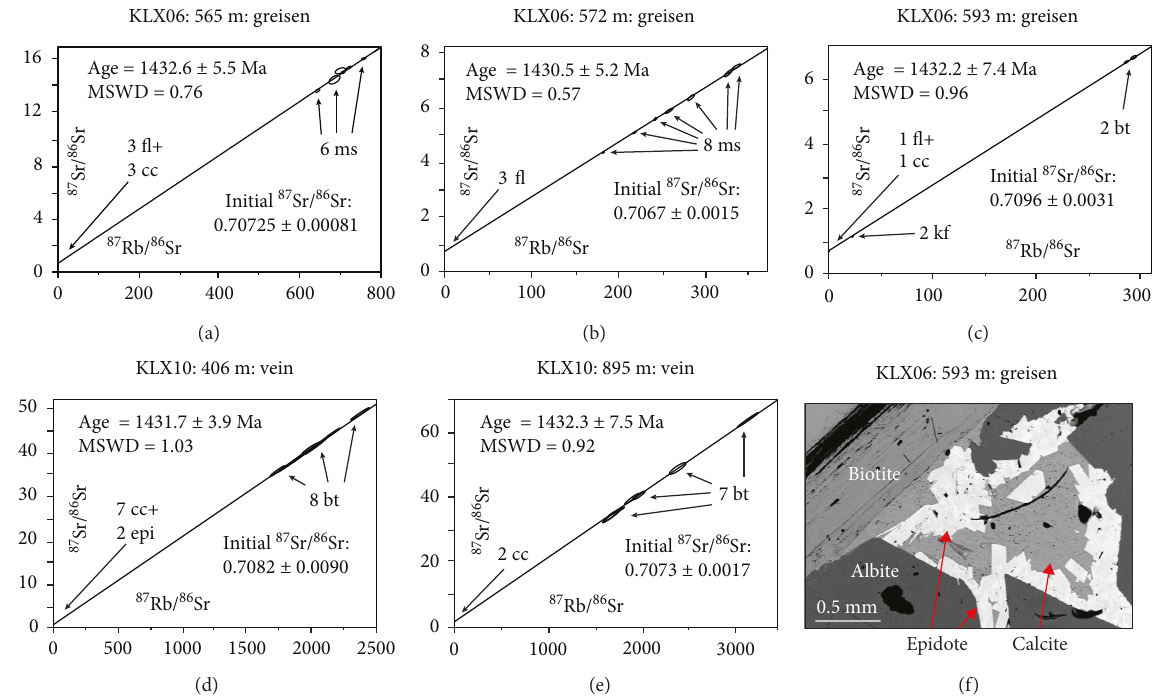
Figure 6: Isochrons of (a – c) greisen and (d – e) vein samples dated by in situ Rb-Sr dating in this study, with ages in 1s. (f) BSE microphotograph of epidote and calcite with albite and biotite in greisen sample KLX06: 593m. bt=biotite, ms=muscovite, kf=K-feldspar, cc=calcite, fl = fl uorite, and